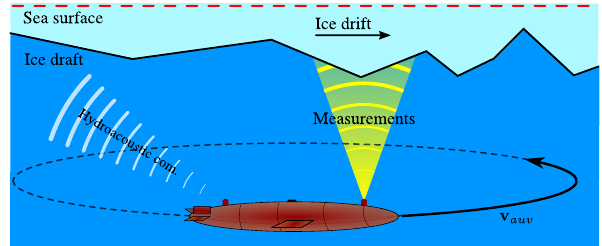
Figure 15: An AUV is measuring the ice draft along a specified path under the drifting sea-ice. Courtesy: Jørgensen and Skjetne (2015) where κ 0 is the fundamental wave number and s is the propagation variable with dynamics ˙ s = v , making the ice field drift with constant velocity v . The coef- ficients a k , b k , k = 0 , 1 , . . . , p give the contribution of the k ’th harmonic in this spatial signal. Stacking the coefficients into the vector c ∈ R m , m = 2 p +1, and the sine and cosine functions in (1) into h ( κ 0 , ξ, p ; s ) ∈ R m , then ϕ ( s ) = h ( κ 0 , ξ, p ; s ) (cid:62) c . The draft at Node i with position x i , i = 1 , . . . , n ,